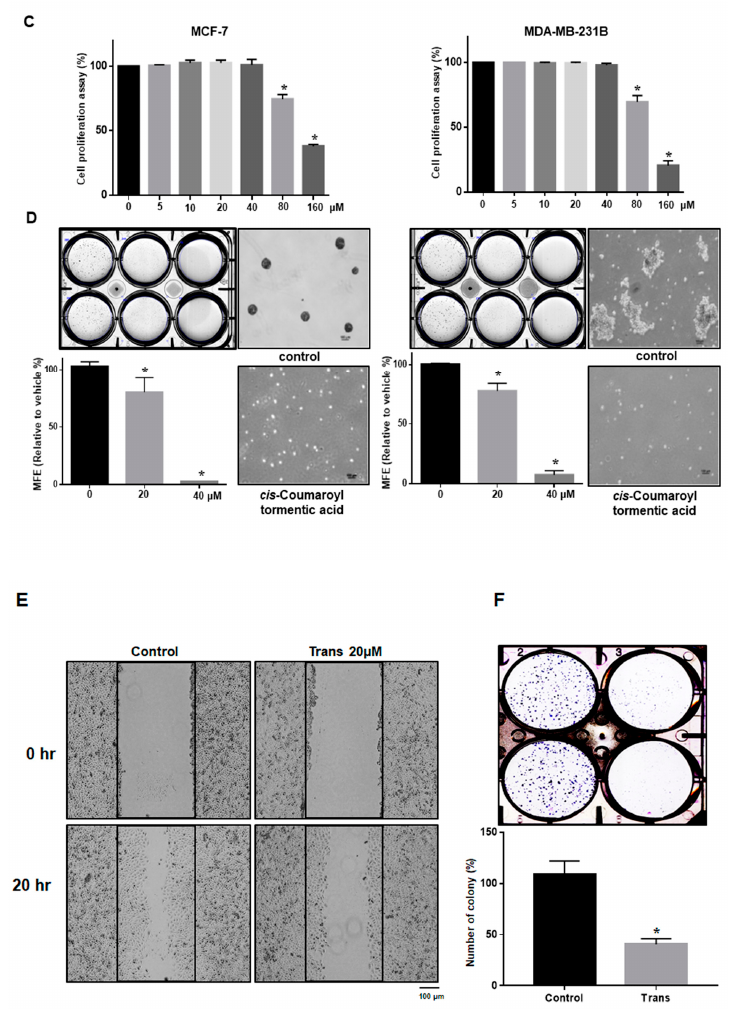
Figure 3. The effect of 3 - O - p -coumaroyltormentic acid on the viability and mammosphere-forming ability of MCF-7 and MDA-MB-231 cells. ( A ) MCF-7 and MDA-MB-231 cells were treated with increasing concentrations of 3 - O - trans - p -coumaroyltormentic acid for 48 h. The antiproliferative effect of 3 - O - trans - p -coumaroyltormentic acid was measured by the MTS (3-(4,5-dimethylthiazol-2-yl)-5-(3- carboxymethoxyphenyl)-2-(4-sulfophenyl)-2 H -tetrazolium) assay. ( B ) Effect of 3 - O - trans - p - coumaroyltormentic acid on the formation of mammospheres derived from MCF-7 and MDA-MB- 231 cells. The mammospheres were incubated with either 3 - O - trans - p -coumaroyltormentic acid (10